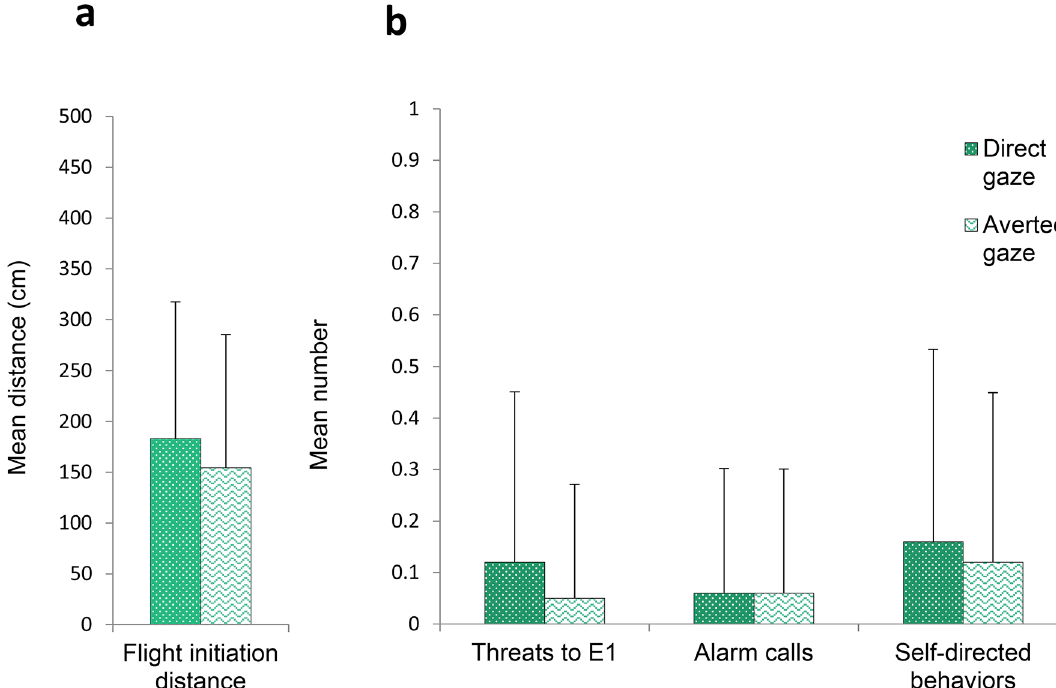
Figure 5. ( a ) Mean flight initiation distance (± SD ) and ( b ) Mean number (± SD ) of threats to experimenter 1 (E1), alarm calls and self-directed behaviors exhibited by the subjects in the Direct gaze and Averted gaze conditions of Experiment 1.